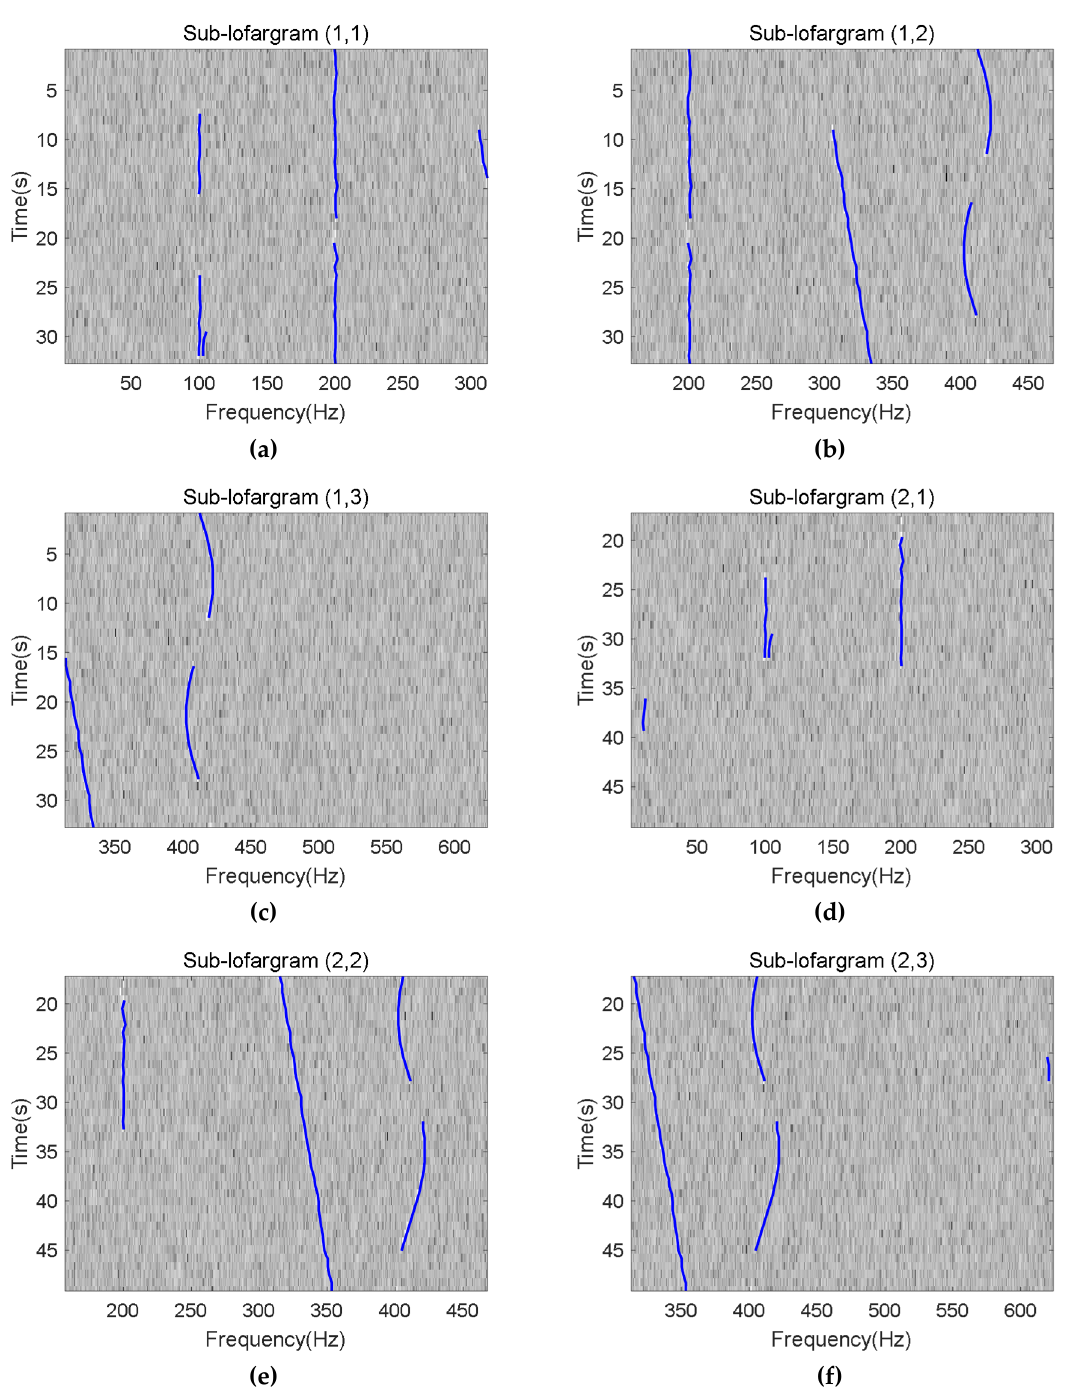
Figure 14. Line tracking results from sub-lofargram (1,1) to sub-lofargram (2,3): ( a ) Sub-lofargram (1,1); ( b ) Sub-lofargram (1,2); ( c ) Sub-lofargram (1,3); ( d ) Sub-lofargram (2,1); ( e ) Sub-lofargram (2,2); ( f ) Sub-lofargram (2,3).